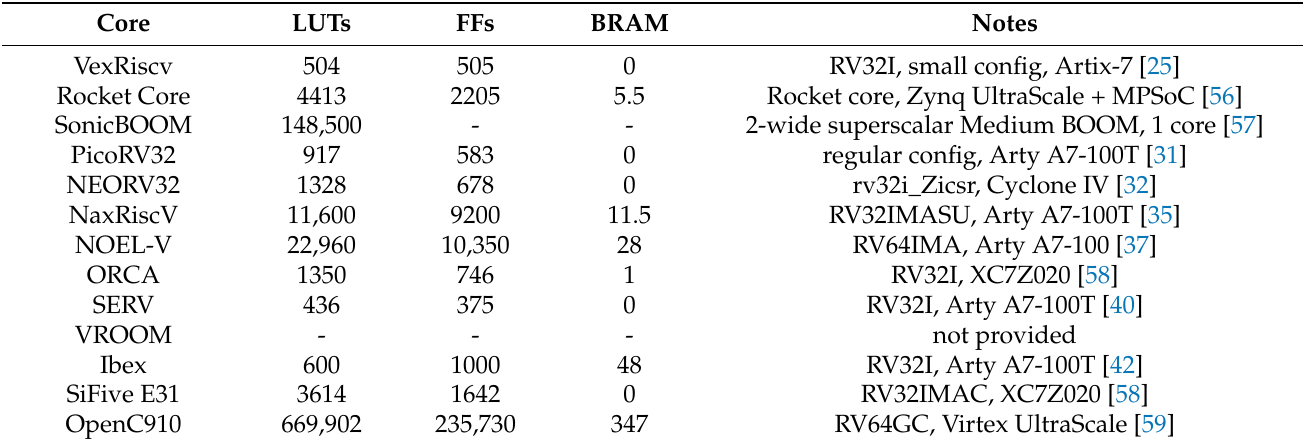
Table 4. RISC-V core implementations on